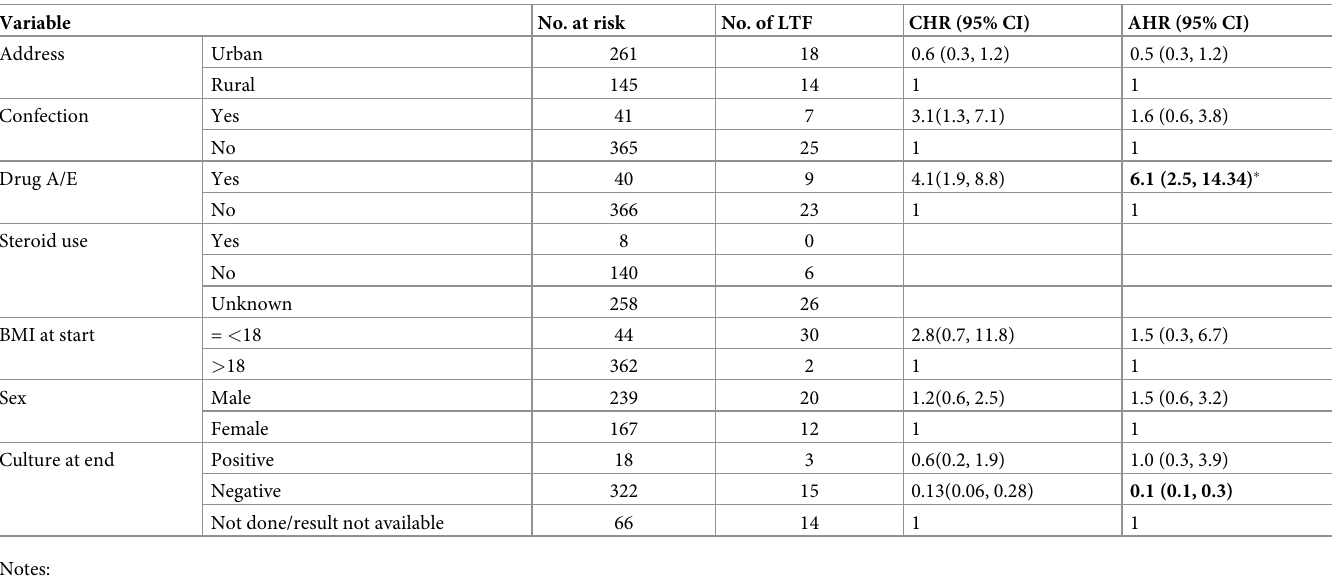
Table 4. Predictors of LTF among drug resistance tuberculosis infected patents in Oromia region, Ethiopia, 2020.